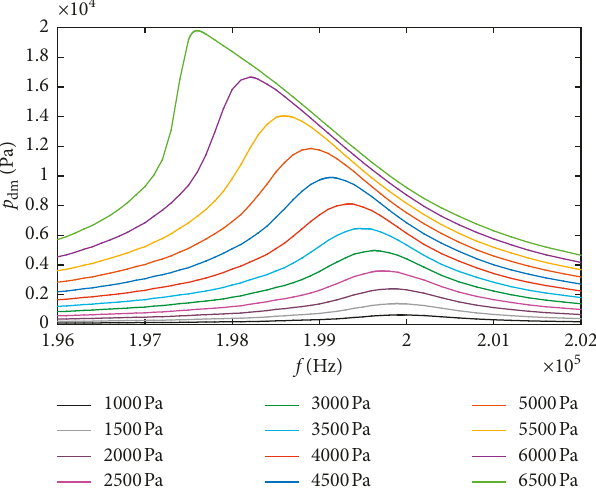
Figure 1: Maximum difference-frequency pressure amplitude in the cavity p in Case